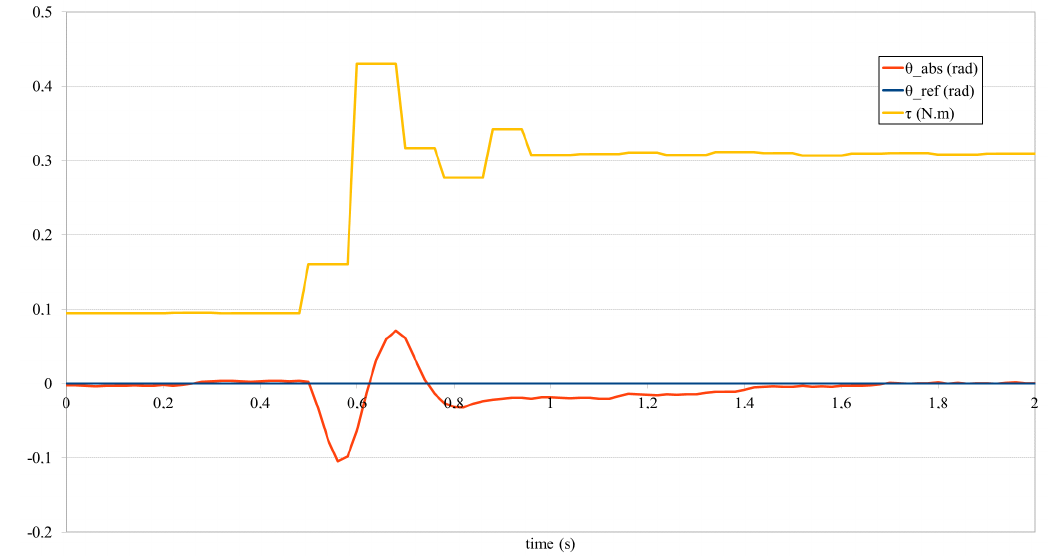
Figure 19. Compliant Controller Disturbance Rejection with Position reference.